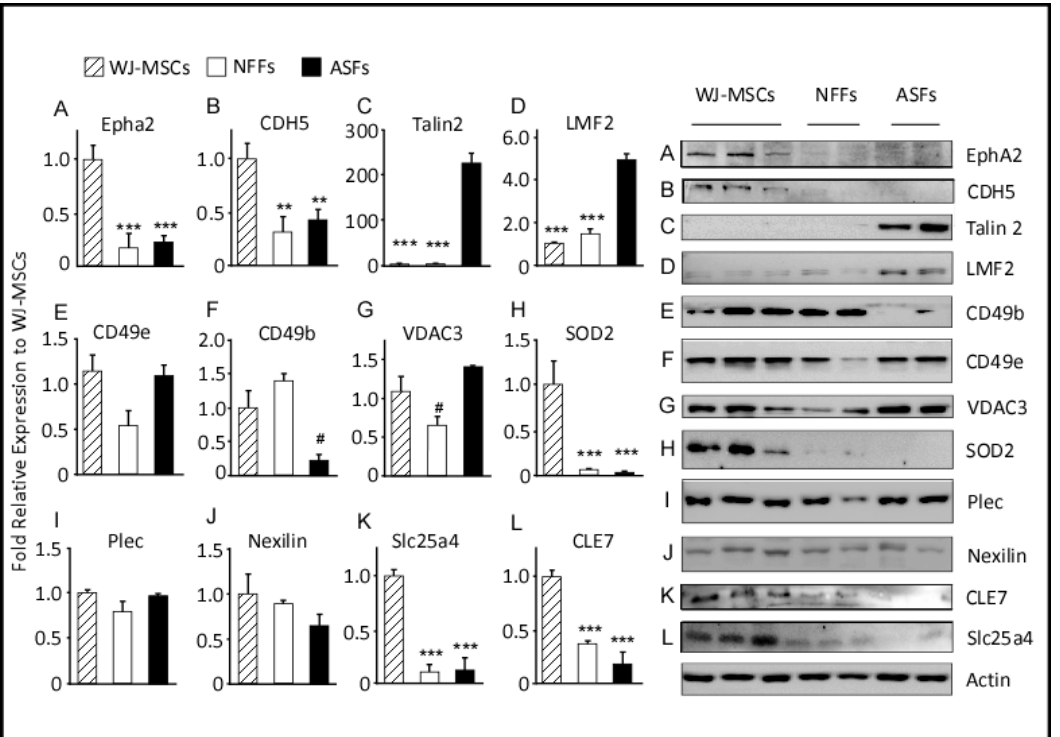
Figure 4. Expression levels of proteins differentially expressed by WJ-MSCs, ASFs, and NFFs. Representative Western blots of 12 expressed proteins. Normalized proteins are expressed relative to their prospective expression in WJ-MSCs. Data are presented as the means ± standard error of the mean of three independent assays. ** p < 0.01, and *** p < 0.001 are significant to the higher bar. # p < 0.01 is significant to all other